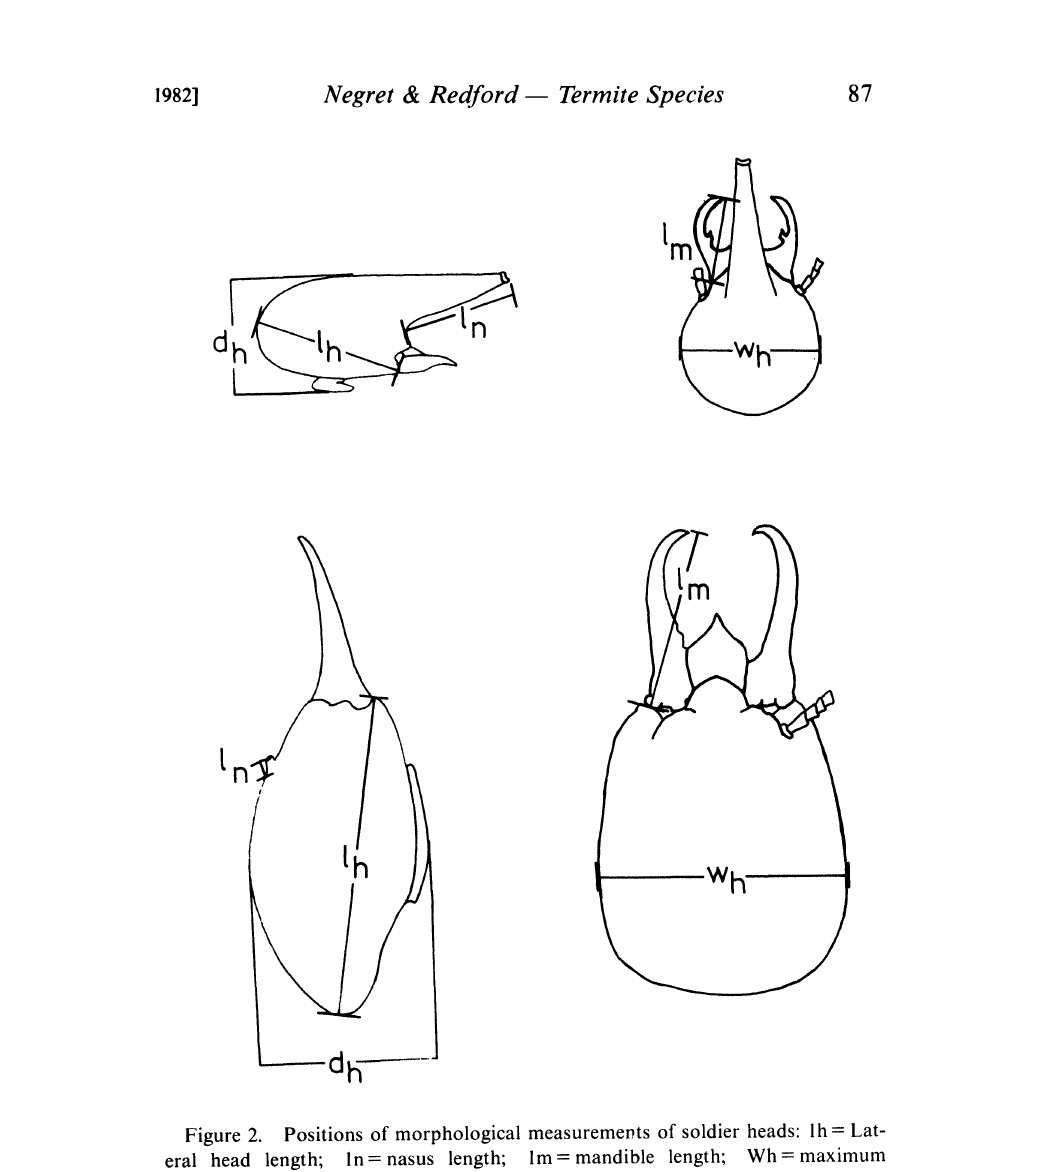
Figure 2. Positions of morphological measuremeots of soldier heads: lh Lat- eral head length; In= nasus length; lm= mandible length; Wh= maximum head width; dh head depth including